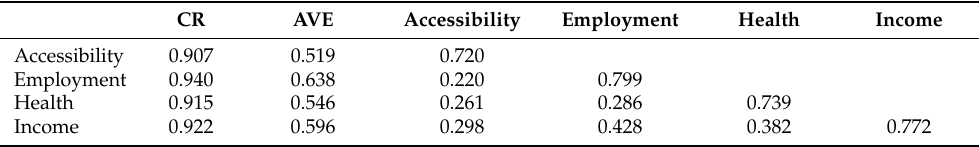
Table 4. Composite Reliability, Average Variance Extracted, and Inter-factor Correlation ( n = 505). CR AVE Accessibility Employment Health Income